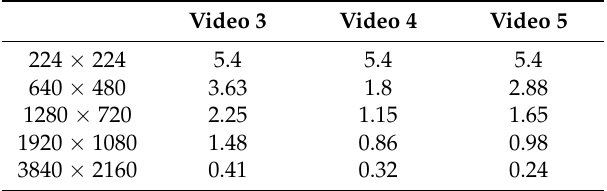
Table 11. Detection speed (number of frames per second) for the second